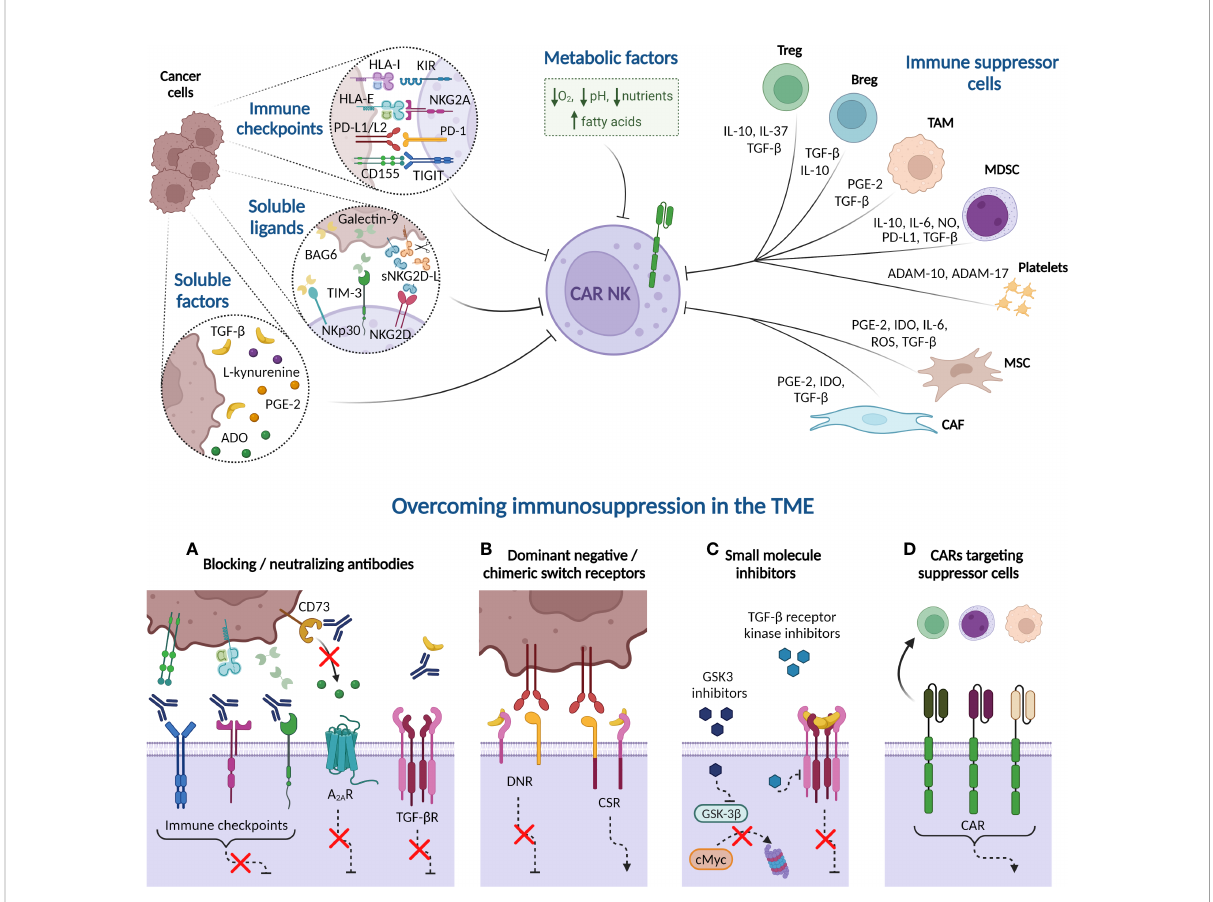
FIGURE 3 Immune suppressive tumor microenvironment (TME) factors potentially involved in CAR-NK cell dysfunction. Cancer cells express immune checkpoint ligands in their plasma membrane that mediate an inhibitory interaction with NK cells. Besides, tumor cells may suppress NK cell function by releasing soluble ligands to the milieu, such as BAG-6, galectin-9, and soluble NKG2D-L (sNKG2D-L), as well as other soluble factors, including cytokines, such as transforming growth factor- b (TGF- b ), enzymes and metabolites. Many of these soluble factors are also produced by immune cells present in the TME, such as Tregs, Bregs, tumor-associated macrophages (TAM), and myeloid-derived suppressor cells (MDSC). Platelets, in turn, secrete the metalloproteinases ADAM-10 and ADAM-17 that prompt NKG2D-L shedding. Other non-immune cells, such as derived-mesenchymal stromal cells (MSC) and cancer-associated fi broblasts (CAF), also produce indoleamine 2, 3 dioxygenase (IDO) or reactive oxygen species (ROS) that reduce NK cell activity. Additionally, hypoxia, high concentrations of fatty acids, nutrient deprivation, and acidity, among other metabolic factors, contribute to generate a complex immunosuppressive TME that hampers the NK cell effectiveness against hematologic malignancies. Several strategies can overcome the immunosuppression mechanism from TME. (A) Blocking antibodies targeting immune checkpoints prevent the inhibition of NK cell cytotoxicity. Other receptors, such as adenosine A2A receptor (A 2A R) also disable NK cell function when binds to extracellular adenosine (ADO). Blockade of CD73 ectoenzyme, which synthetizes ADO, reduces the levels of this metabolite in the TME, therefore increasing NK cell killing activity. Furthermore, anti-TGF- b neutralizing antibodies impede the NK cell suppressive effect unleashed by the interaction of this cytokine with its receptor (TGF- b R). (B) Dominant-negative receptor (DNR) expression hinders the inhibitory signaling triggered by PD-1 and TGF- b R in the presence of PD-L1/L2 or TGF- b , respectively. Chimeric switch receptors (CSR) constitutes another approach based on replacing these negative signals by activating ones, through intracellular domains exchange, reverting the outcomes in NK cell activity. (C) Small molecule inhibitors directed against GSK-3 b impact on NK cell metabolism and improve their cytotoxic potency. Other inhibitors are engineered to inhibit the kinase activity of TGF- b R. (D) CAR constructs are designed against molecules expressed in immune suppressor cells to eliminate them from TME. HLA-I, HLA class I histocompatibility antigen; KIR, Killer- cell immunoglobulin-like receptor; HLA-E, HLA class I histocompatibility antigen, alpha chain E; PD-L1, Programmed Death ligand-1; PD-1, Programmed Death 1; TIGIT, T cell immunoglobulin and ITIM domain; BCL2-associated Athanogene 6 (BAG-6); sNKG2D-L, soluble natural killer group 2D ligands; TIM-3, T cell immunoglobulin and mucin-domain containing-3; PGE-2, prostaglandin E2; NO, nitric oxide; A Disintegrin And Metalloproteinase (ADAM). Created with